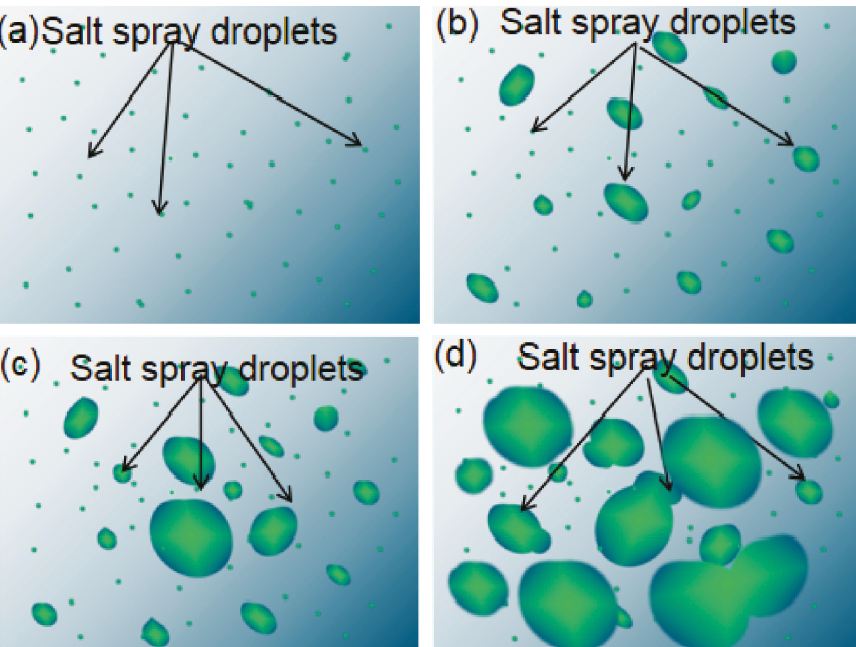
Figure 2: The formation and evolution model of salt spray droplets: (a) salt spray droplets adsorbed and spread on the surface; (b) the smaller salt spray droplets get together to form larger droplets; (c) part of the smaller or larger salt spray droplets deeply get together; (d) most part of the surface was covered with the larger salt spray droplets.